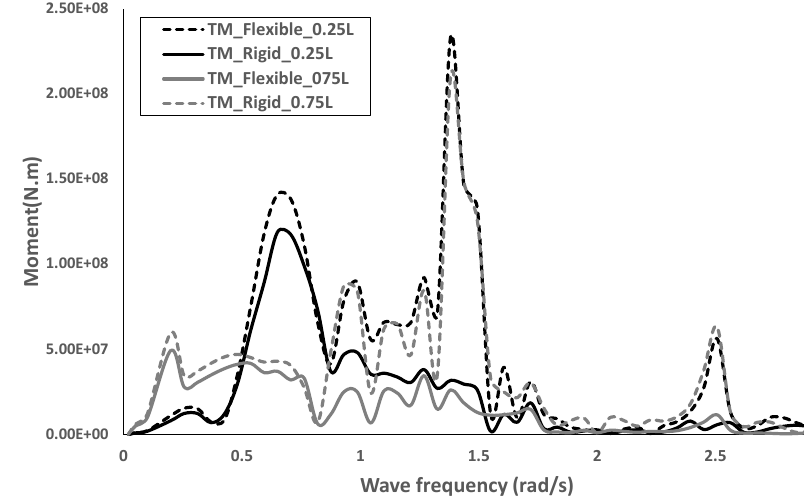
Figure 11. Load transfer function TM (torsional moment).